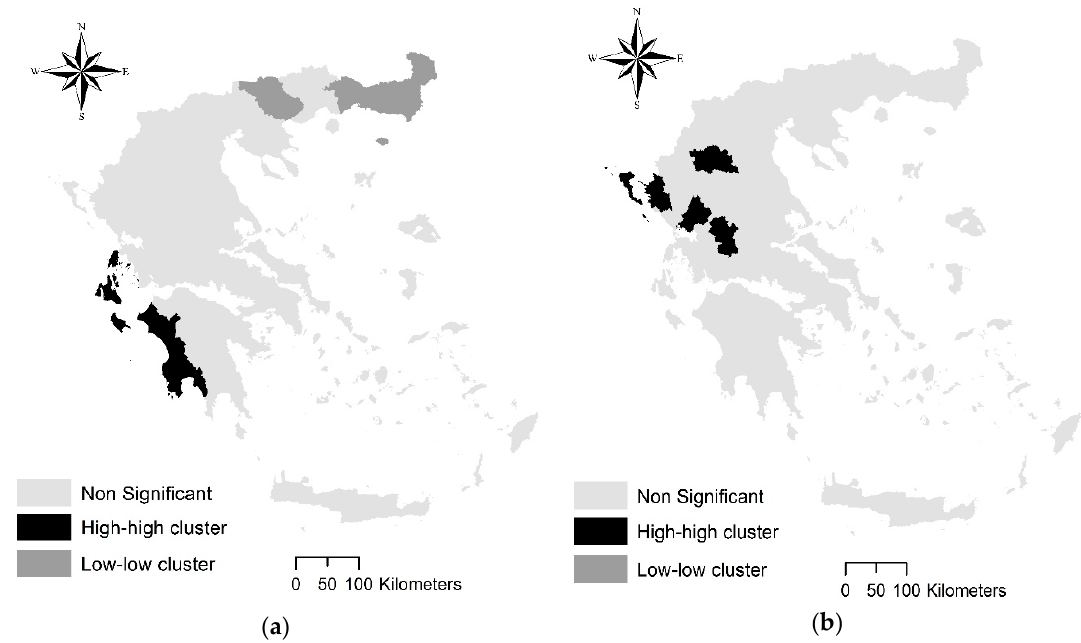
Figure 4. Local Moran’s spatial autocorrelation index ( z -score) of the gender gap (years) in the mean age at marriage by year and bandwidth (km); significant coefficients (high-high or low-low) at p < 0.05 (1980: ( a ); 2017: ( b )).